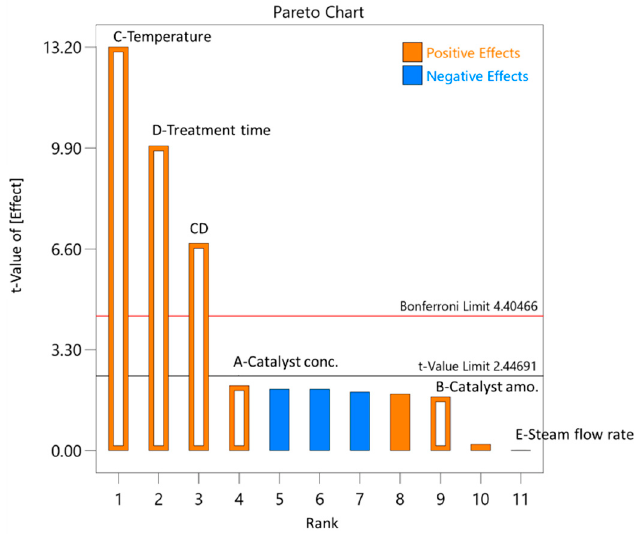
Figure 5. Influence of pre-treatment process parameters on 2-furaldehyde formation.